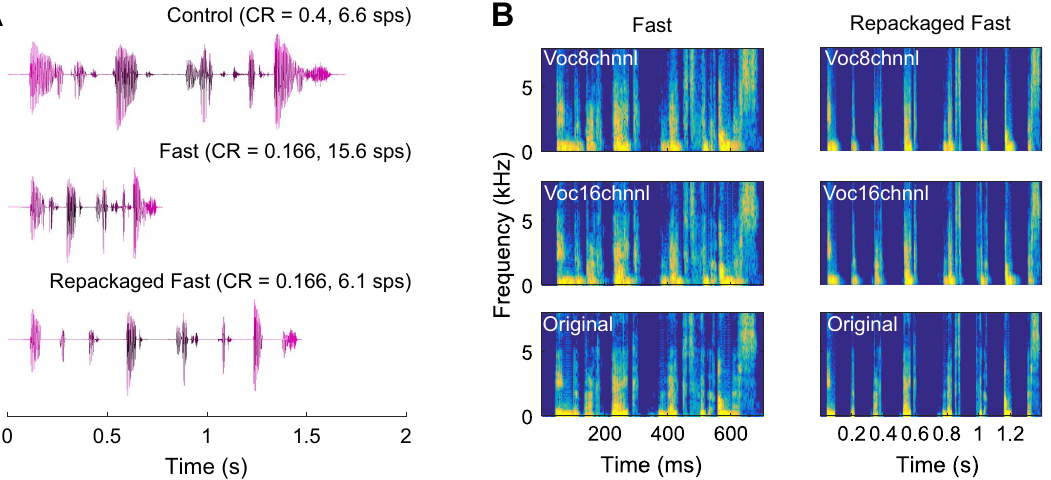
Figure 1. ( A ) The time waveforms of the sentence “in de praktijk werkt het anders” (“in practice it works differently”) when TC with a compression rate (CR) of 0.4 (i.e., control condition) and 0.166 (i.e., fast condition), and the repackaged fast condition by adding 100 ms of silence between the syllables. ( B ) The spectrograms, of the same sentence as in ( A ), of the different TFS content for both the fast (left) and repackaged fast (right)